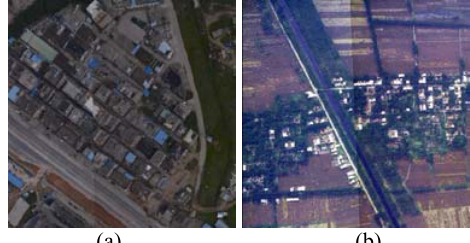
Figure 5. (a) The problem caused by matching errors, (b) the problem caused by exposure differences.